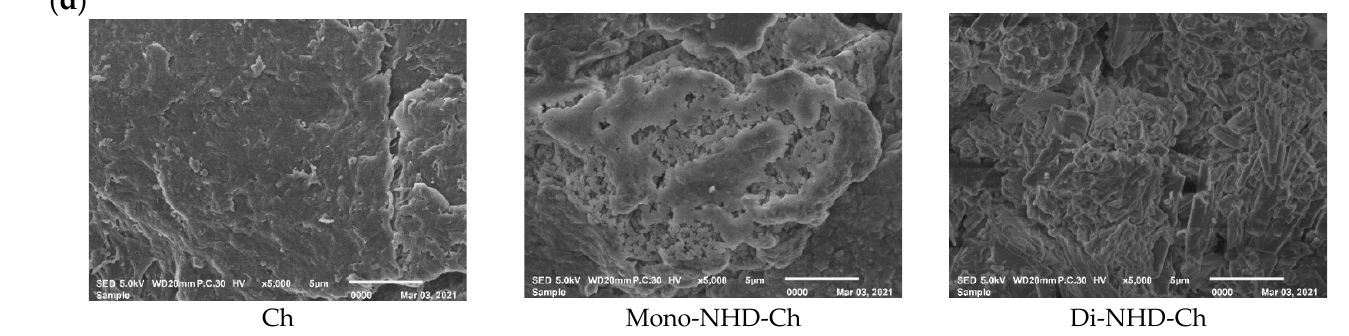
Figure 2. ( a ) FT-IR of chitosan and its alkyl derivatives. ( b ) Electronic spectra of chitosan and its alkyl derivatives. ( c ) Thermal analysis of chitosan and its alkyl derivatives: ( C1 ) TGA analysis and ( C2 ) DSC analysis. ( d ) SEM images of chitosan and its alkyl derivatives.